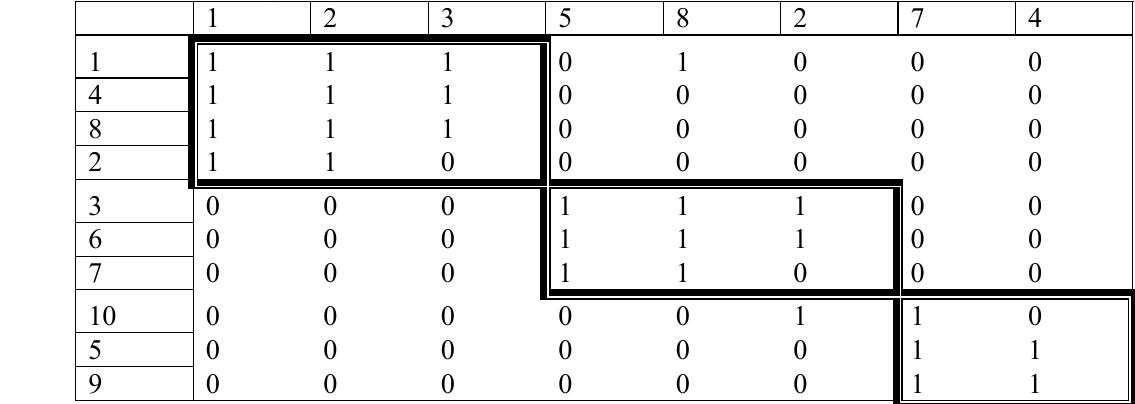
Final solution matrix Y for problem 1